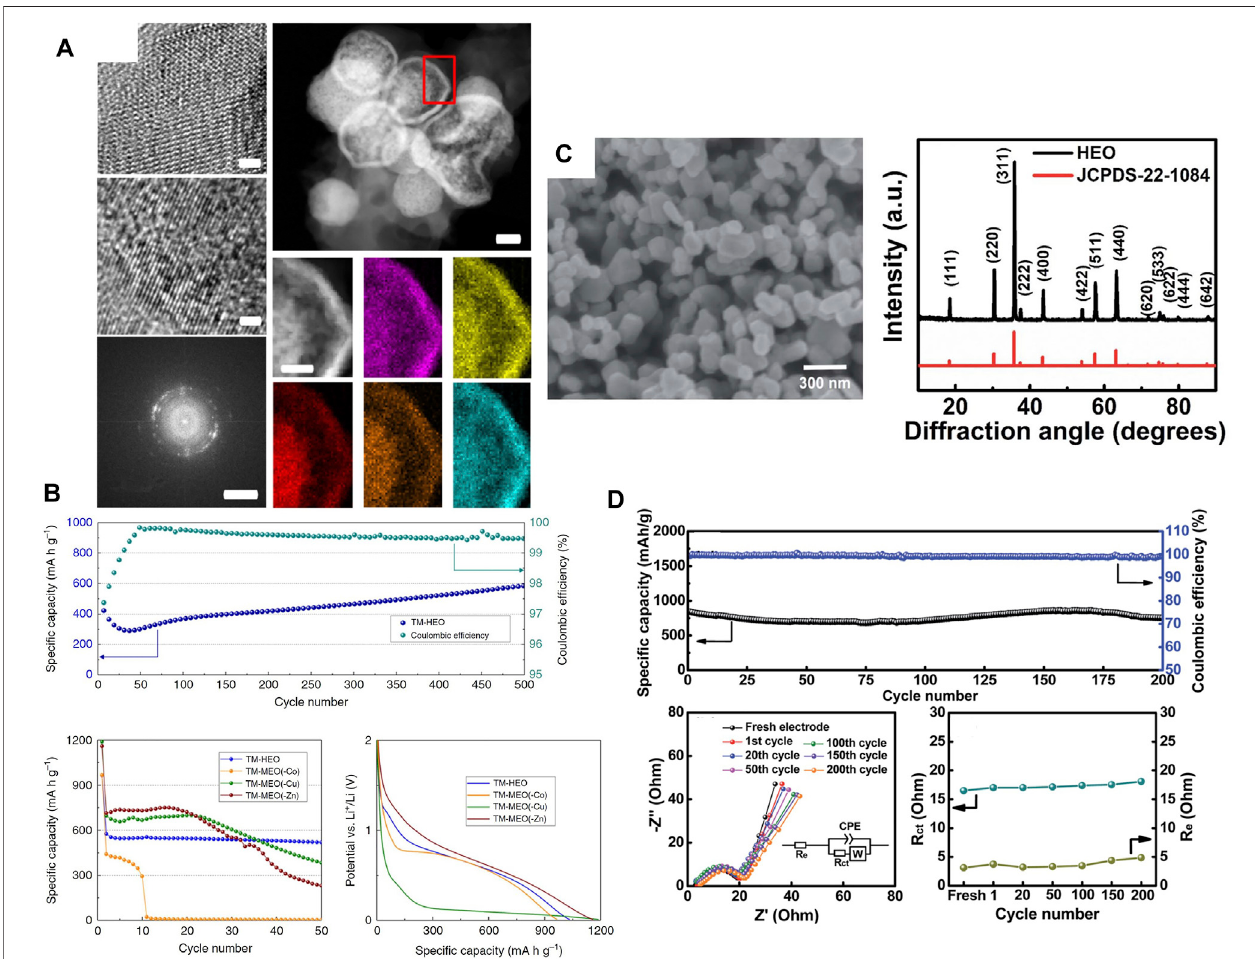
FIGURE 2 | (A) HR-TEM and EDX characterization of rock-salt HEO and (B) cycling performance and voltage pro fi les of high-entropy and medium-entropy oxide anodes (Sarkar, et al., 2018a). (C) SEM and XRD characterization and (D) cycling performance and impedance of spinel HEO anode (Nguyen et al., 2020). Reproduced underthetermsoftheCCBYlicense.Note:ForFigureA,thescalebarsintheHRimagescorrespondto1nm.FortheEDXcolourmap,thescalebarcorrespondsto60nmandthe colours correspond to: purple-Co, yellow-Cu, red-Ni, orange-Mg, blue-Zn.